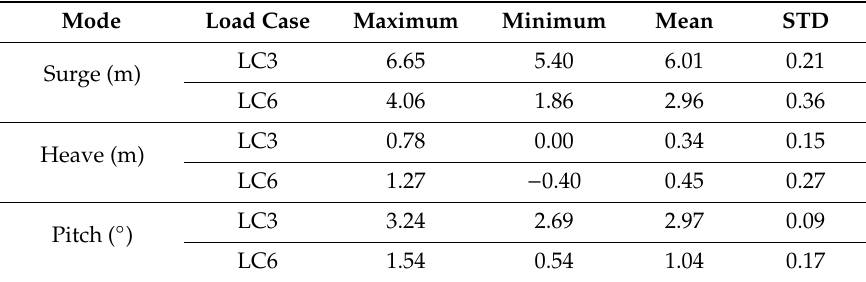
Table 9. Statistics of platform motions of the 5 MW FOWT.